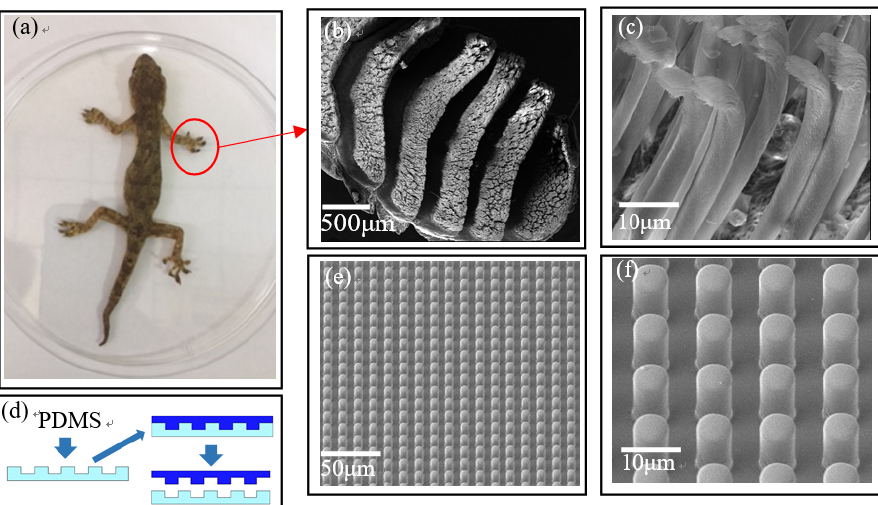
Figure 8. ( a ) The photo of the gecko, ( b ) scanning electron micrograph of a gecko’s toe, ( c ) the extended scanning electron micrograph of a gecko’s toe. ( d ) The PDMS was taken from the silicon plate to obtain an adhesion sheet. ( e ) The gecko-inspired setae array, ( f ) the extended image of the gecko-inspired setae array.